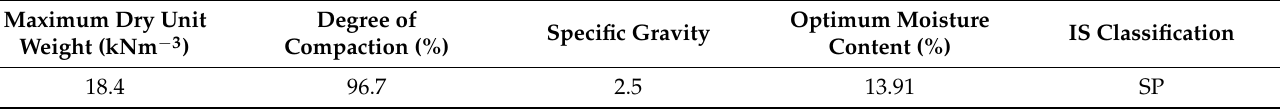
Table 1. Index properties of the confined granular